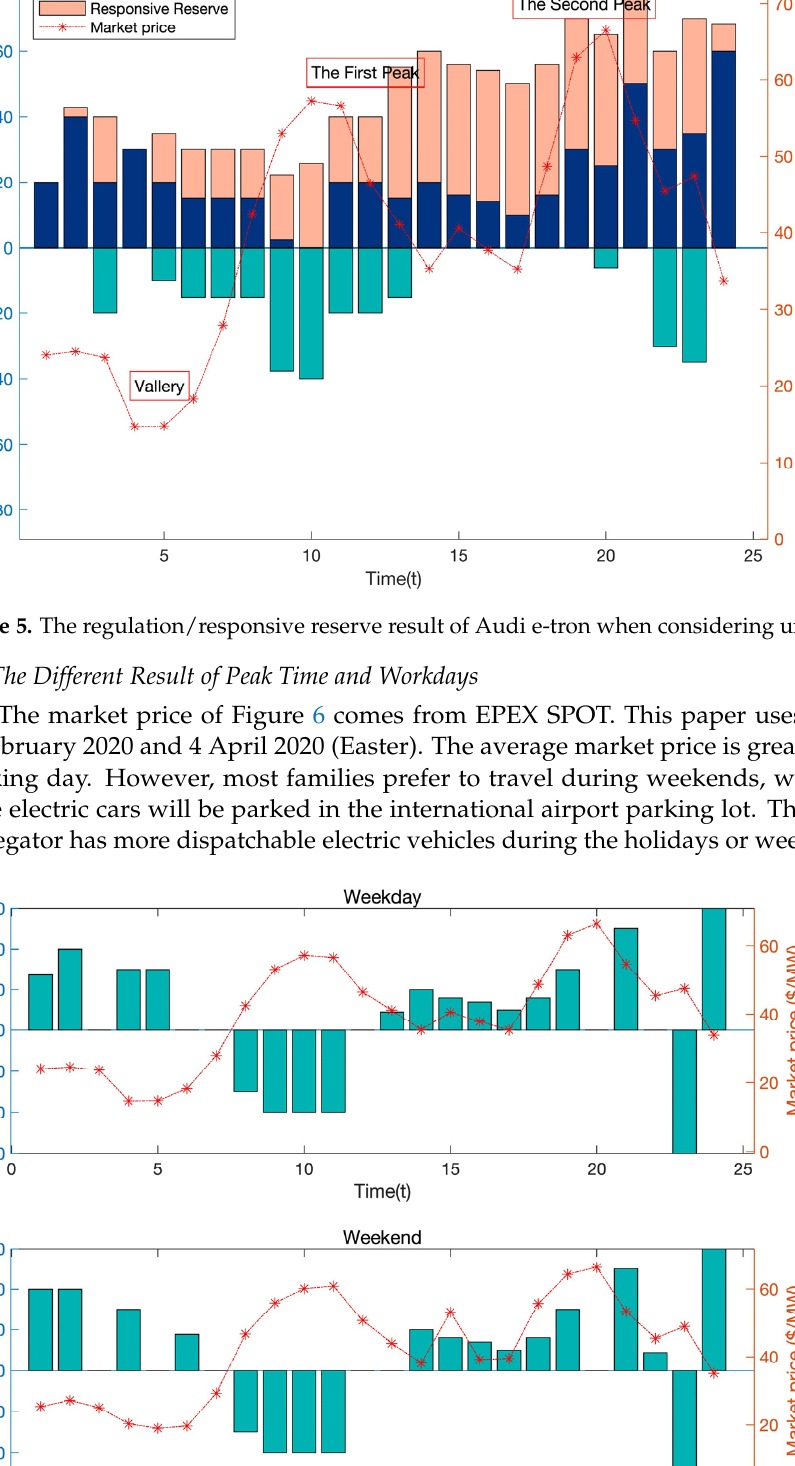
Figure 7. Comparison of regulation and responsive reserve result of Audi e-tron. At the same time, Figure 8 shows the proportion of regulation down, regulation up and responsive reserve on weekdays and weekends. Compared to working days, the pro- portion of response reserves has increased by approximately 5%. The basic trend of elec- tric vehicle behavior is the same as before. However, as passenger traffic increases during the weekends, aggregators can arrange more dispatchable electric vehicles. Therefore, the average power consumption is greater than the working day. When the number of electric